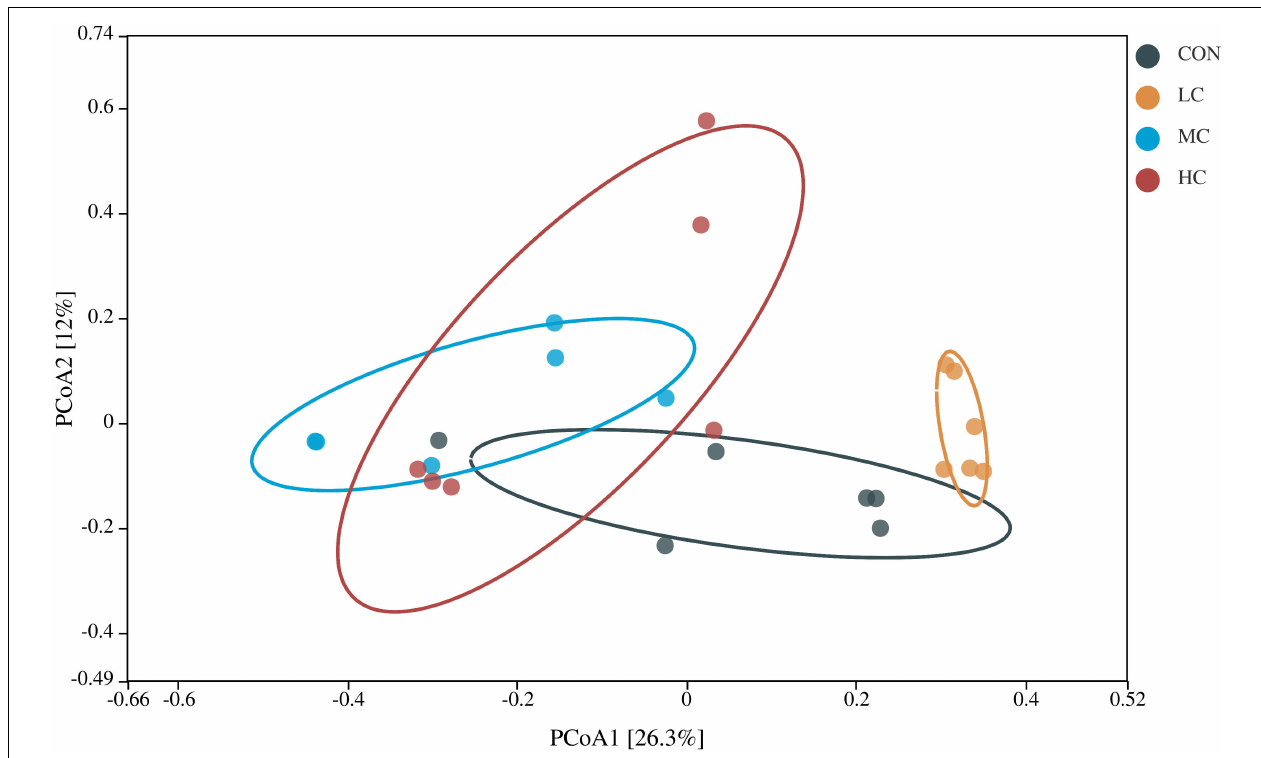
FIGURE 2 | Principal coordinates analysis of rumen microbiota in different treatment groups.